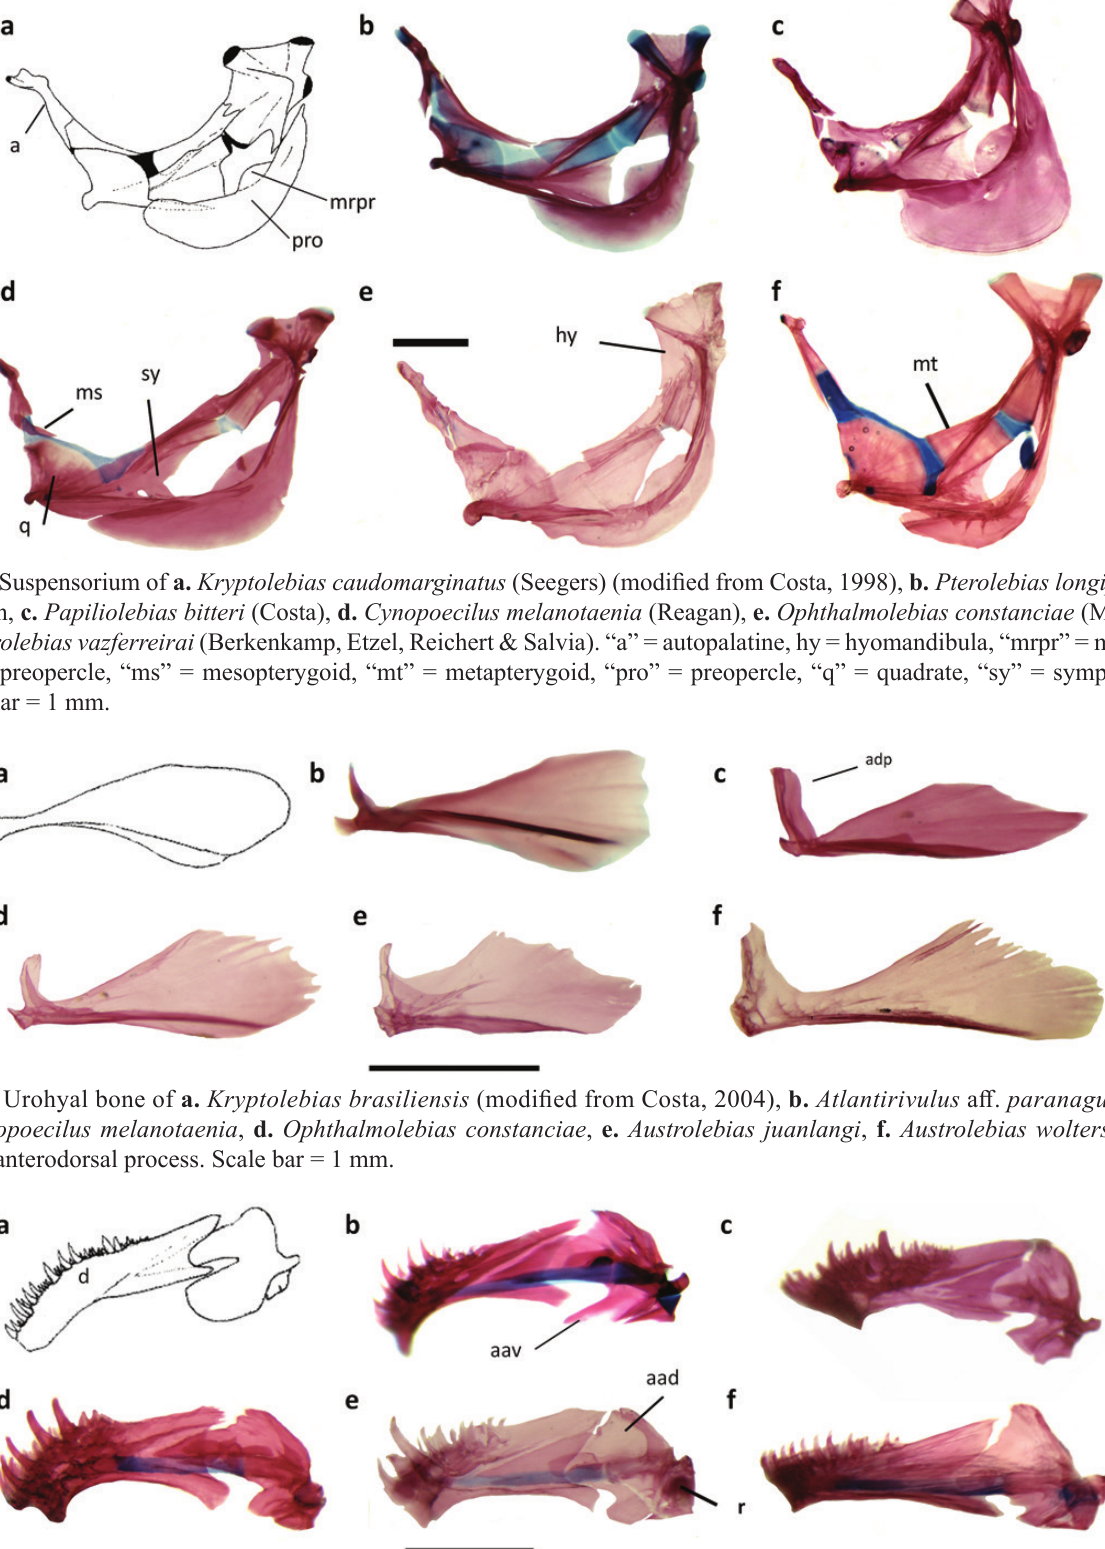
Fig. 3. Lower jaw of a. Kryptolebias brasiliensis (modified from Costa, 2004), b. Pterolebias longipinnis, c. Papiliolebiass bitteri , d. Cynopoecilus melanotaenia , e. Austrolebias juanlangi , f. Austrolebias wolterstorffi ; aad = anguloarticular dorsal process, aav = anguloarticular ventral process, d = dentary, r = retroarticular. Scale bar = 1